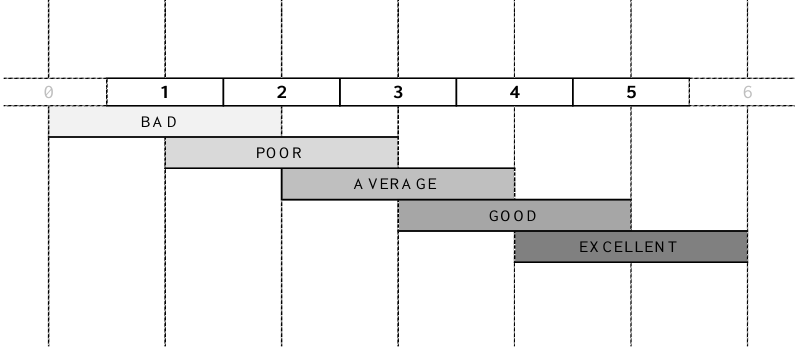
Figure 2. Condition rating scale used in this study.